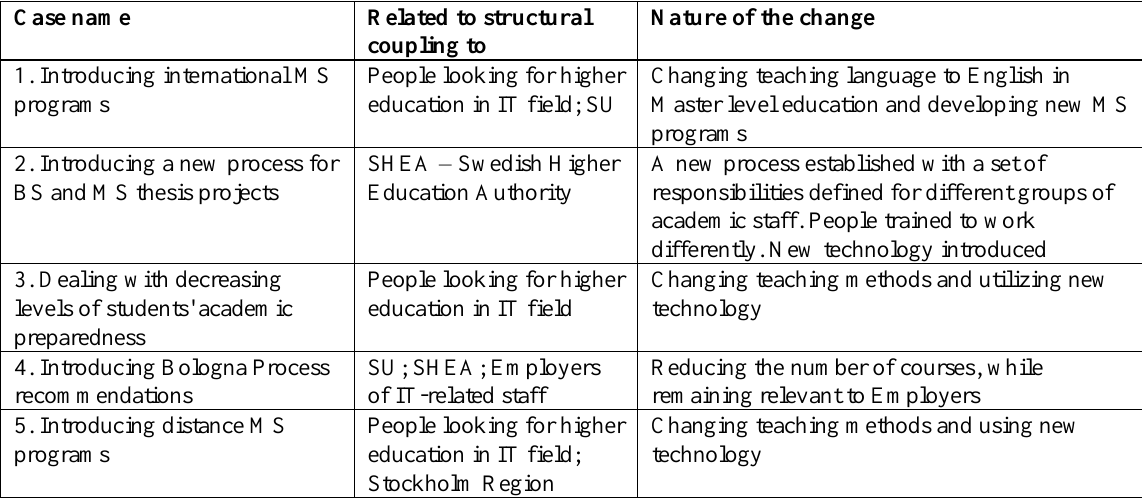
Table 3. Summary of